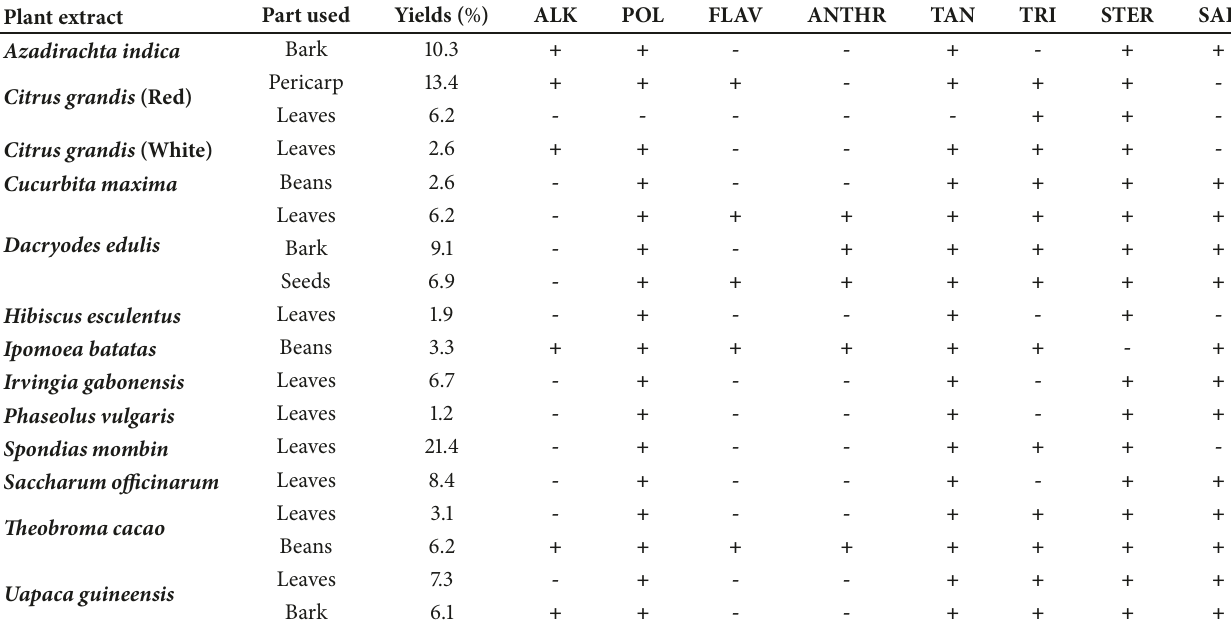
Table 1: Extraction yields and phytochemical composition of the plant extracts. Plant